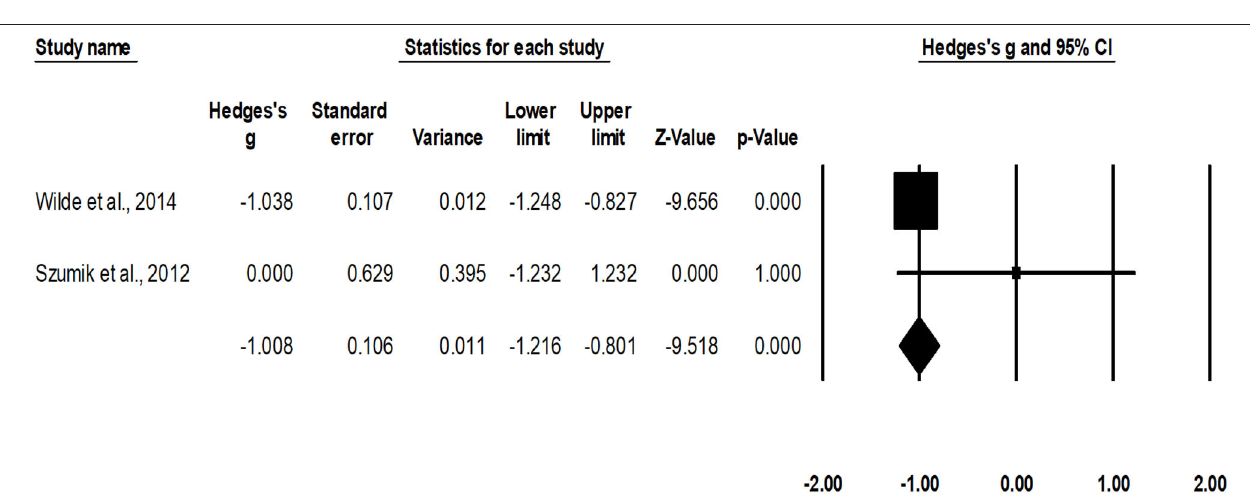
tumor (13), and recurrence (53). Nevertheless, its ability to limit renal function as a result of substantial resection of unaffected renal tissue has raised questions concerning its efficiency (24, 54, 55). In addition, nephrotoxic effects of cancer therapies, genetic predisposition (WT1 mutation), and hyperfiltration injury have also been reported to contribute toward worsening renal function. Cost et al. (37) for instance, reported a reduction in renal function in children operated with radical